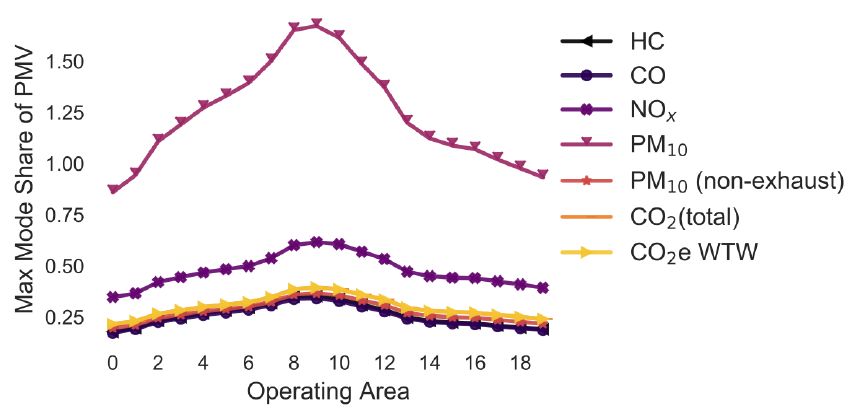
Figure 11. Maximum share of customers who can pick up a parcel by car (varying level of service) (note: CO 2 (total) and CO 2 e WTW are the same).